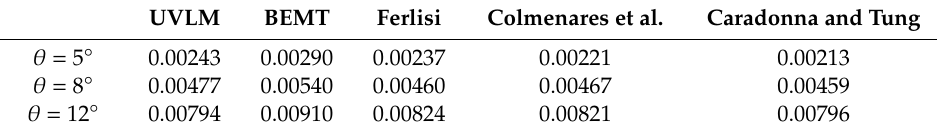
Table 4. Average C T predictions by different numerical methods versus experimental values. UVLM BEMT Ferlisi Colmenares et al. Caradonna and Tung